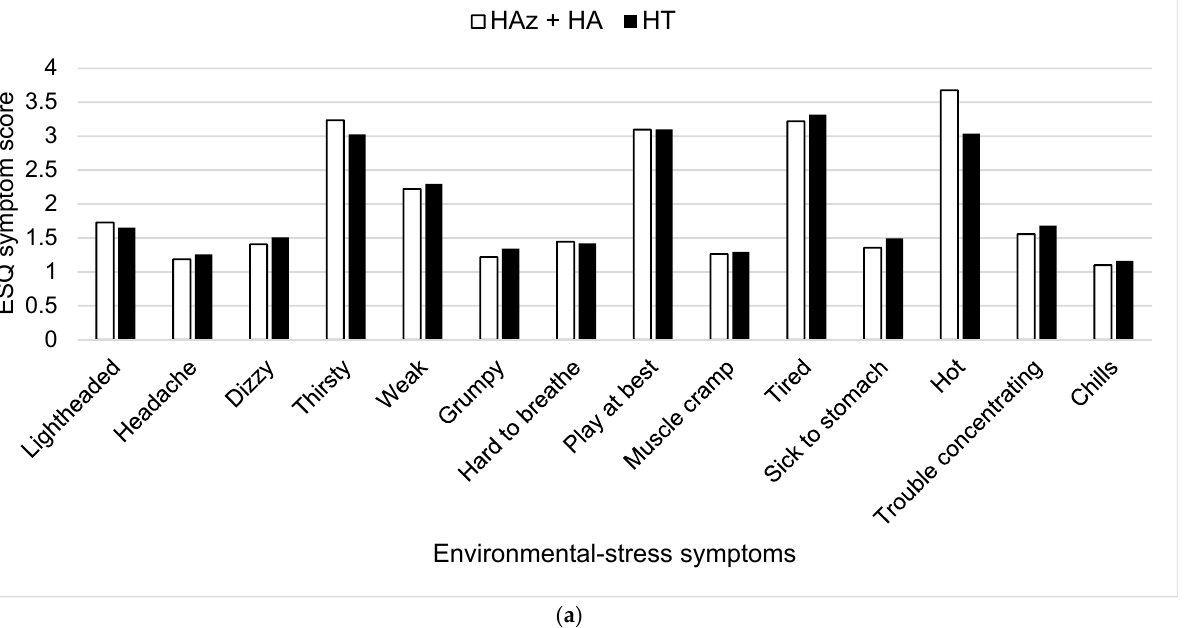
1 ± 0 Superscript letters indicate statistical significance of post-ESQ symptoms from baseline to post-HA and from post-HAz to post-HA ( p < 0.05). Table 2. Means and standard deviations (Ms ± SDs) of post-trial Environmental Symptoms Ques- tionnaire (ESQ) total scores for maximal heat training group (HT MAX ), minimum heat training group (HT MIN ), and the control group (HT CON ) after heat acclimation (post-HA), at week 4 of HT (post- HT4), and at week 8 of HT (post-HT8). Groups were split post-HA prior to beginning HT (post-HT4 and post-HT8). Group summaries were extrapolated from post-HA to help track environmental symptom changes that occurred over HT. Post-HA (M ± SD)